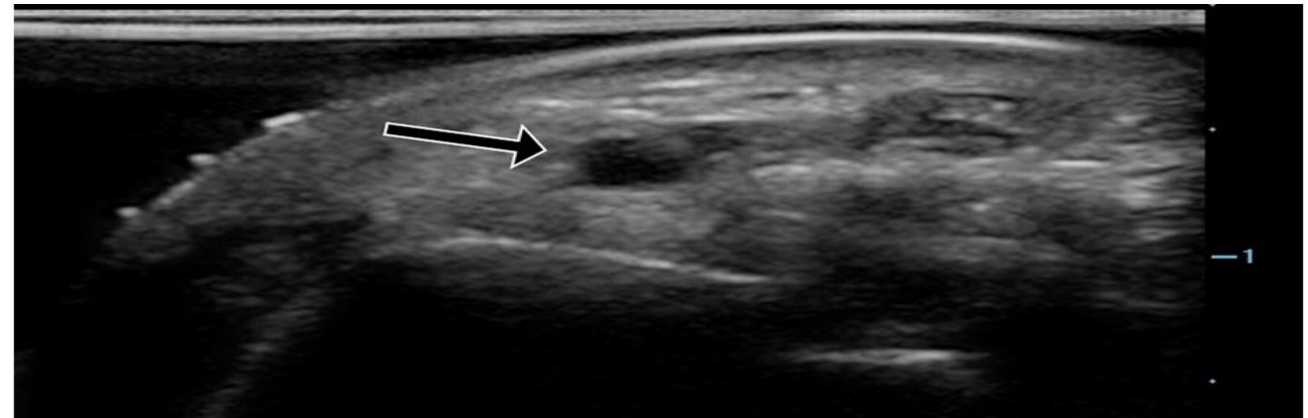
Figure 4a. Ultrasound of the radial artery showing normal anatomy